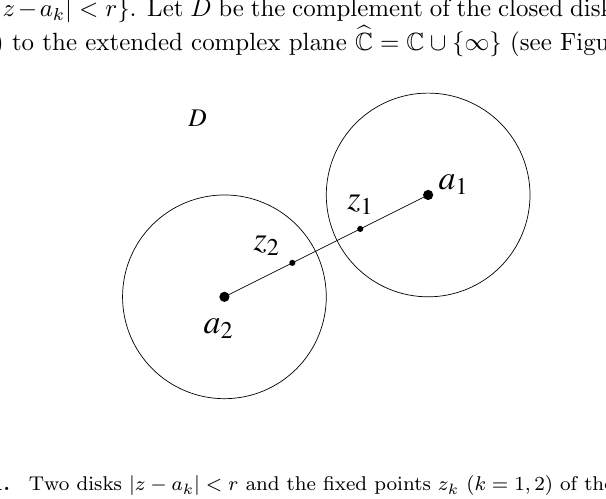
Figure 1. Two disks | z − a k | < r and the fixed points z k ( k = 1 , 2) of the map ( z ∗